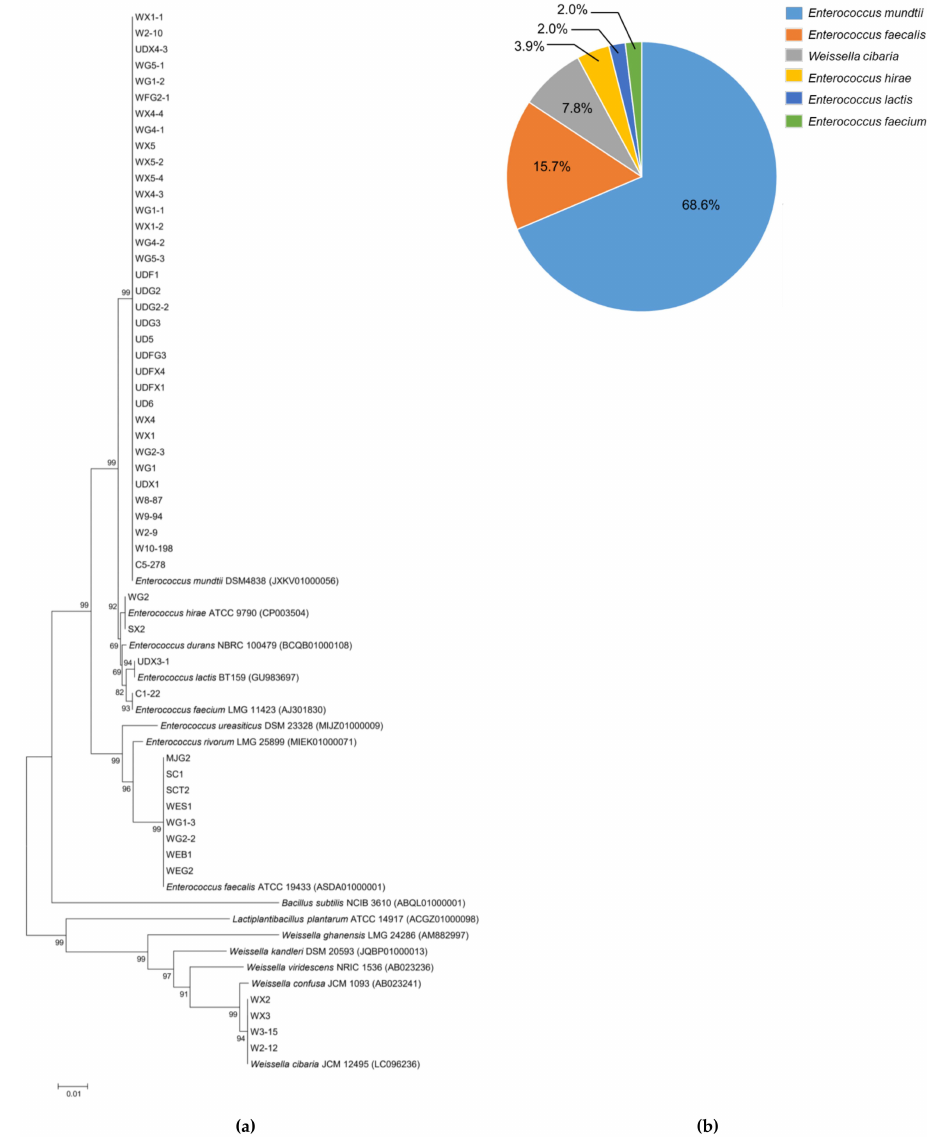
Figure 2. Phylogenetic tree based on the 16S rRNA gene sequence analysis ( a ) and the proportion percentage of the identified species ( b ) of 51 selected LAB from Eri silkworm